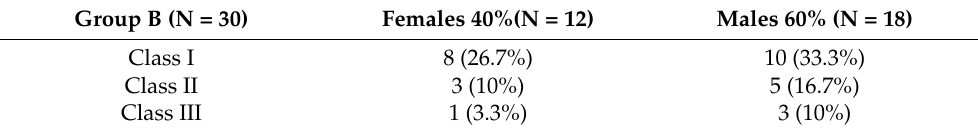
Table 2. Absolute frequency and percentage ( n (%) values) of Group B in the different skeletal Classes. Group B (N = 30)